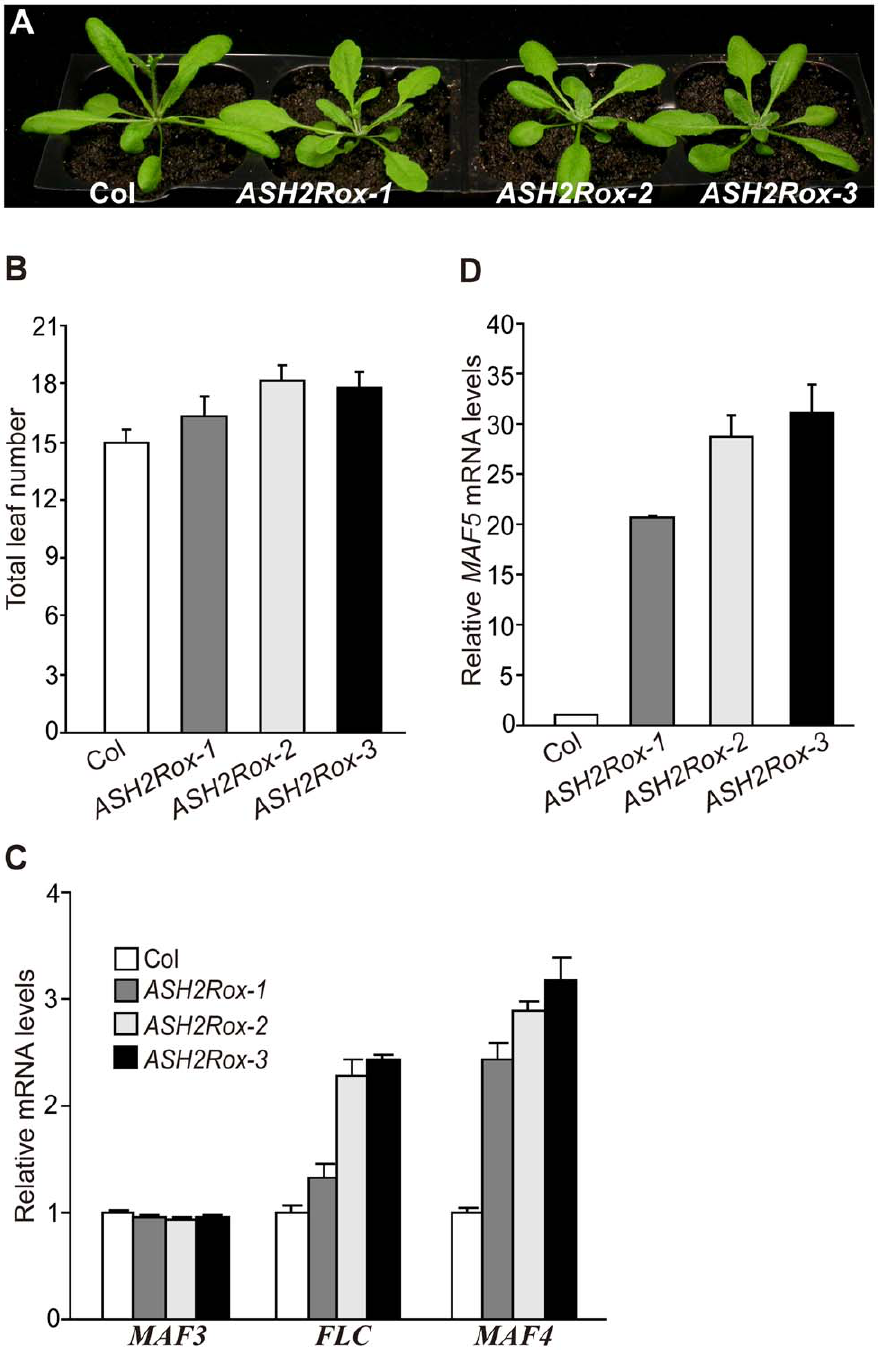
Figure 5. Overexpression of ASH2R Activates the Expression of FLC , MAF4 , and MAF5 to Delay Flowering. (A) Phenotypes of ASH2R overexpression lines grown in LD. (B) Flowering times of ASH2Rox lines grown in LD. Total leaf number at flowering for each line (11 plants per line) was counted. Error bars indicate SD. (C) Relative mRNA levels of FLC , MAF3 and MAF4 in ASH2Rox and Col seedlings determined by real-time quantitative PCR. Relative expression to parental Col is presented. Bars indicate SD. (D) Relative MAF5 mRNA levels in ASH2Rox and Col seedlings.